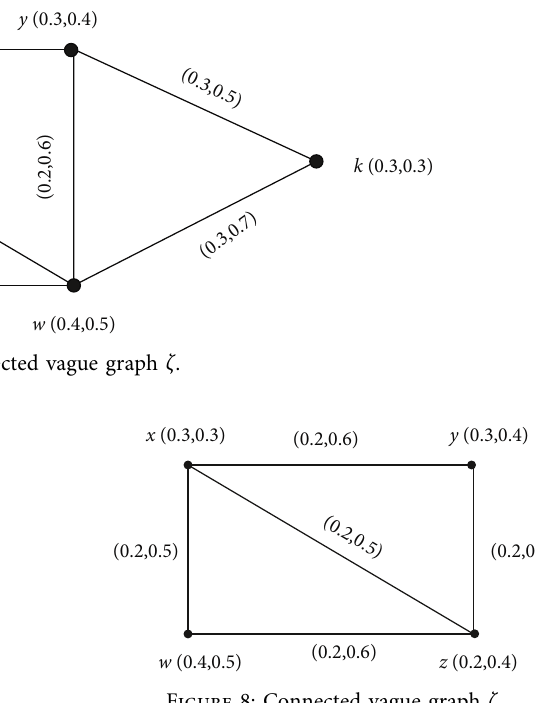
Figure 6: Vague graph ζ and its complement ( ζ ) .